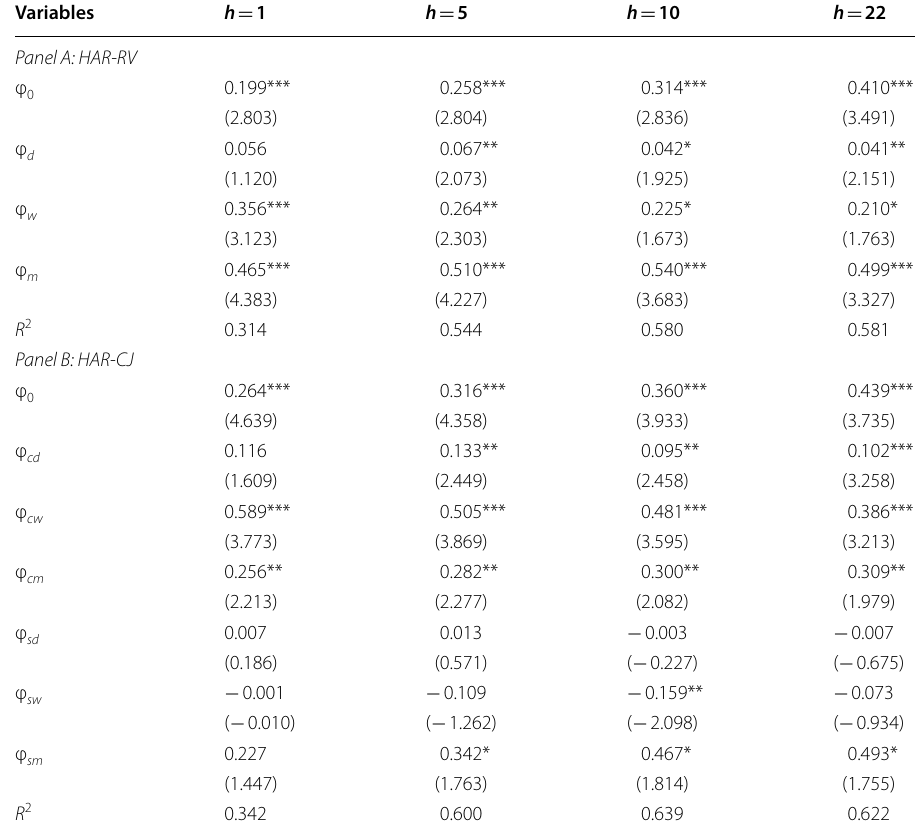
Table 1 Full-sample estimation results of the HAR-RV and HAR-CJ